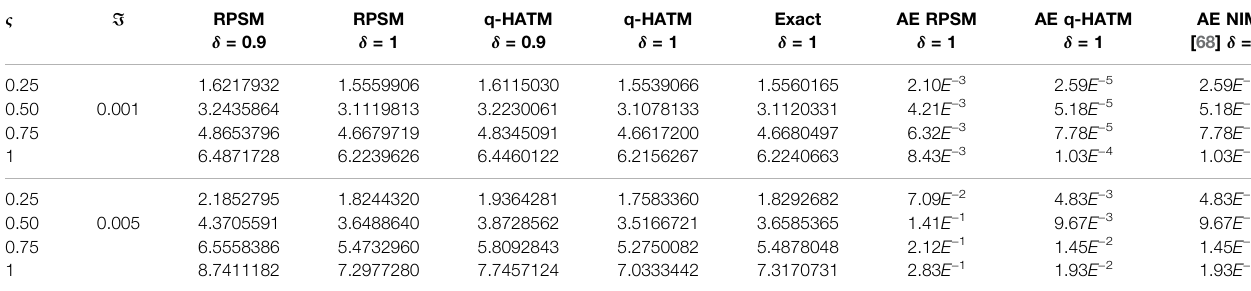
TABLE 1 | A comparison of RPSM, q-HATM and exact for various values of ς and I .